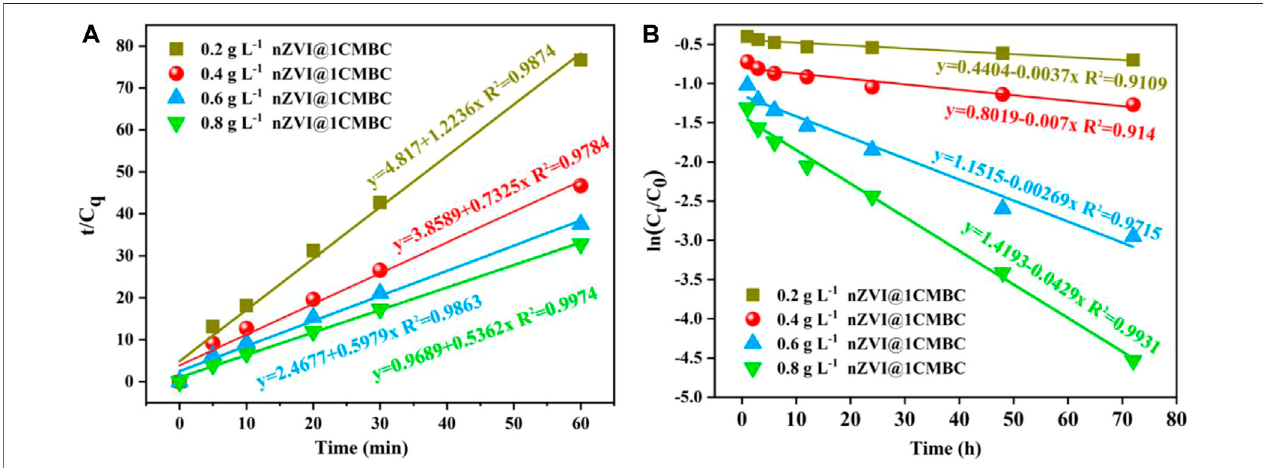
FIGURE 5 | Kinetics of Cr(VI) adsorption onto nZVI@1CMBC, quasi-second order adsorption kinetics model (A) , and quasi- fi rst order reaction kinetics model (B) .